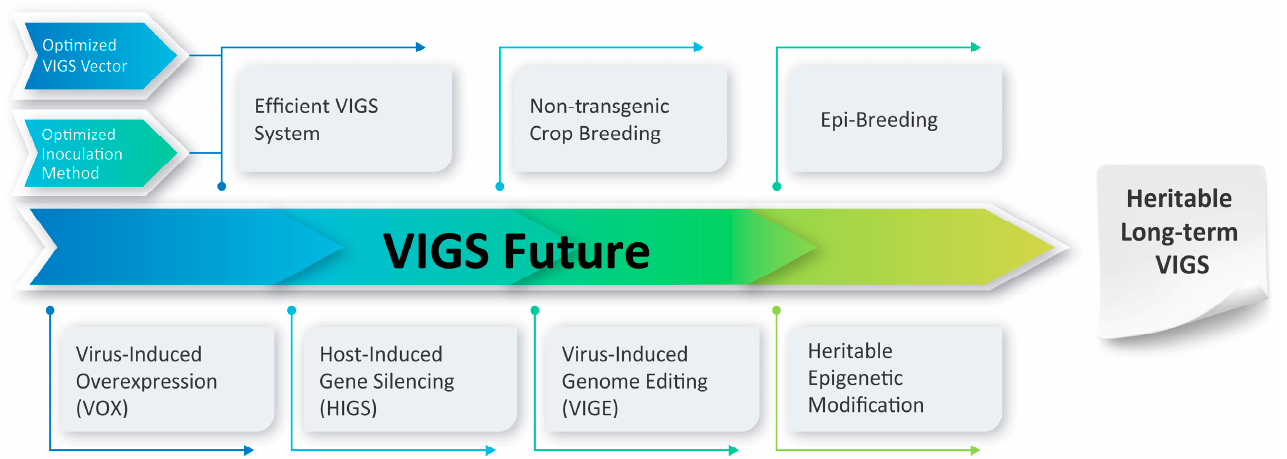
Figure 4. Future Direction of VIGS.